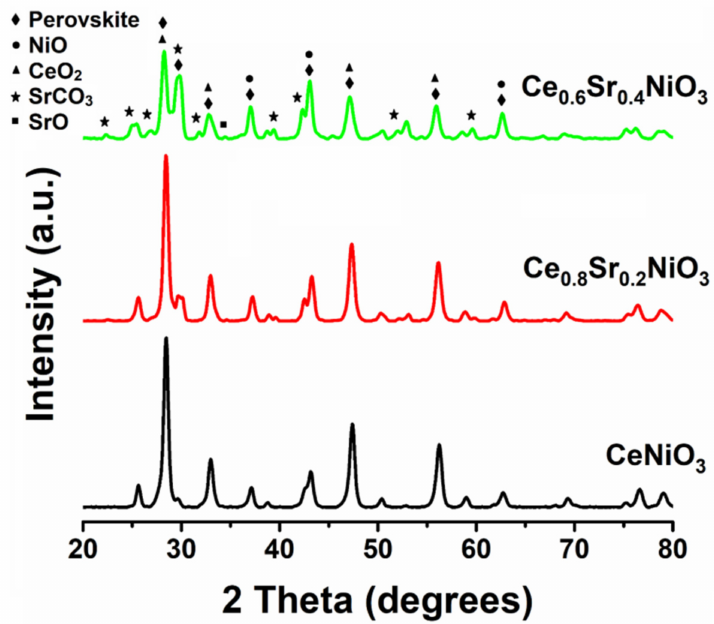
Figure 2. XRD patterns of Ce x Sr 1 − x NiO 3 (x = 0.6–1)